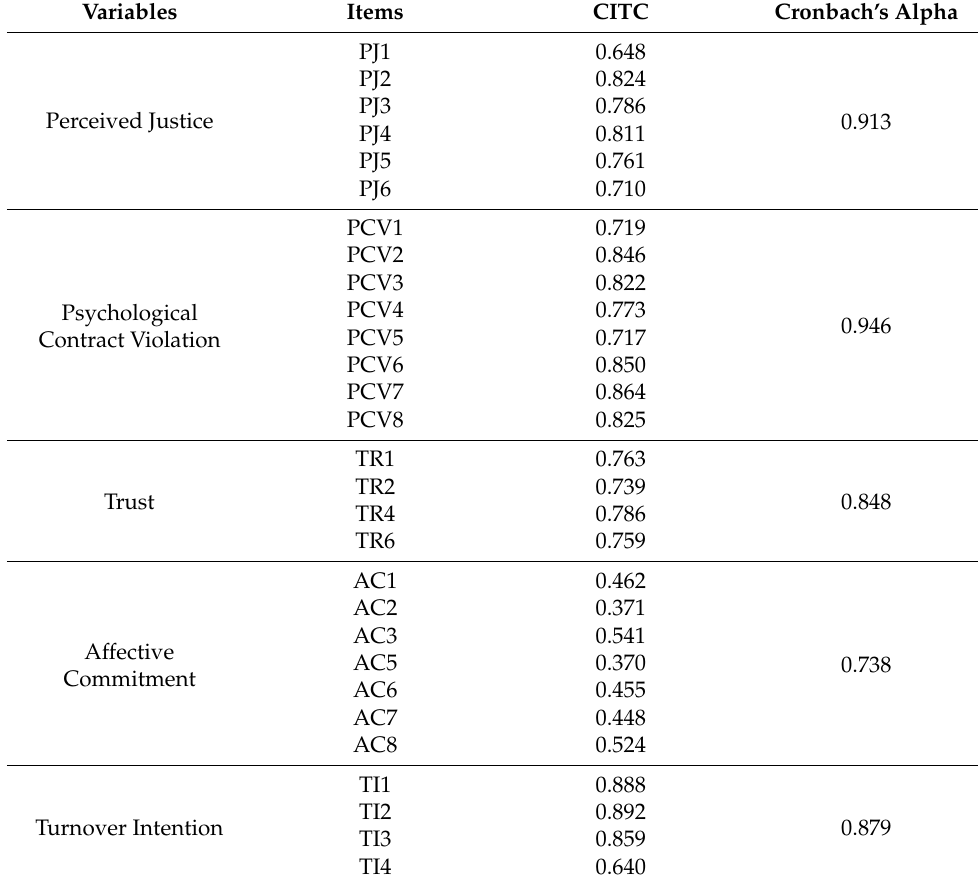
Table 3. Reliability of the